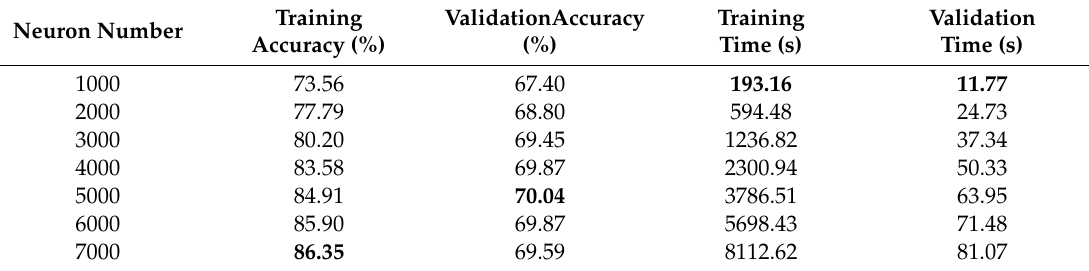
Table 2. Influence of hidden neuron number on the overall